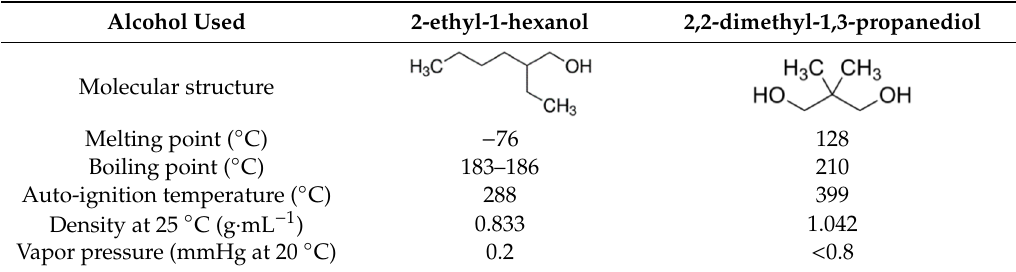
Table 1. Main characteristics of the alcohols used for biolubricant production from cardoon fatty acid methyl esters (FAMEs).